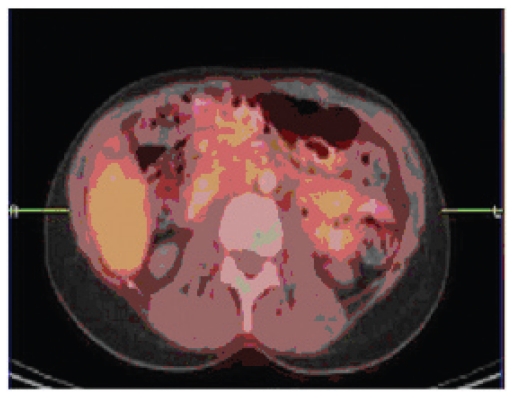
After Treatment.